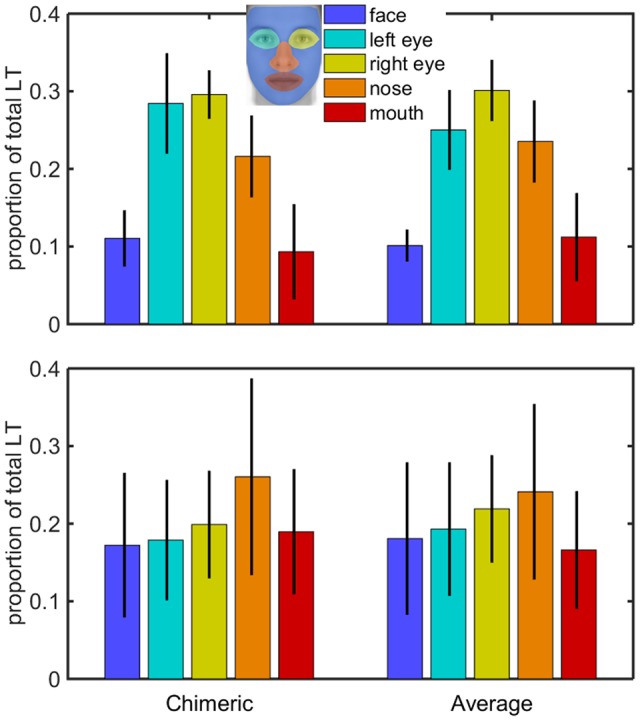
Proportion of looking time in AOI for the hearing (Top) and deaf (Bottom) group. Black bars give the 95% confidence interval for the mean proportion of looking time.